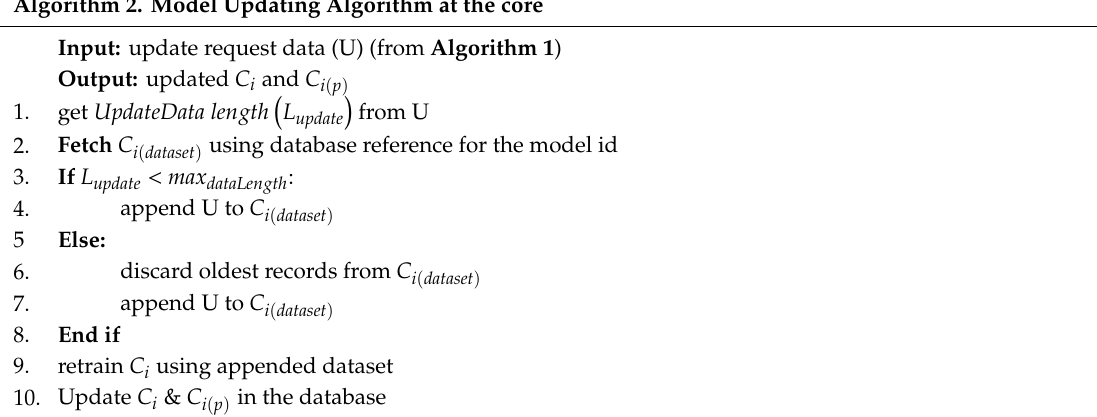
Algorithm 2. Model Updating Algorithm at the